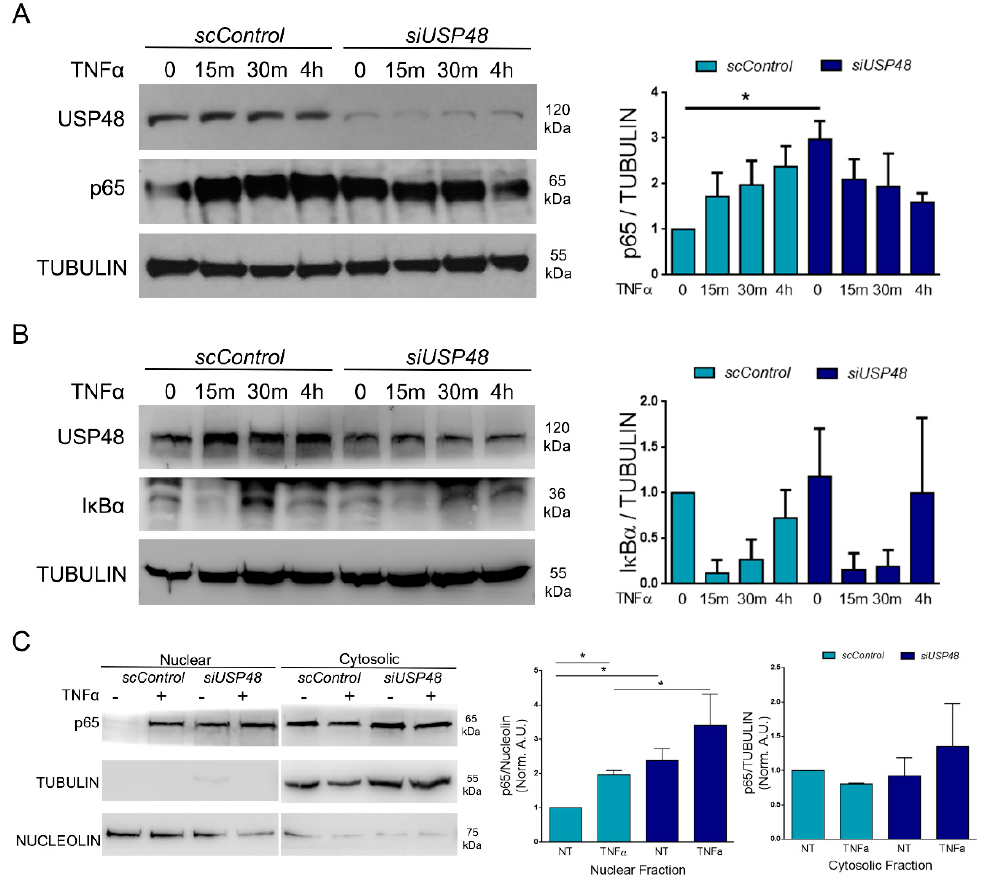
Figure 4. USP48 downregulation stabilizes p65, mainly in the nuclear compartment. USP48 expres- sion was downregulated in hTERT-RPE1 cells at both basal conditions (NT) and after treatment with TNF α at several different time points. Cells were harvested and processed for immunoblotting. ( A ) Densitometric quantification indicates that p65 levels significantly increased in NT cells. ( B ) No changes were detected in I κ B α expression levels. ( C ) Nuclear and cytosolic extracts were prepared for immunoblotting with anti-USP48 and p65 antibodies. Anti-nucleolin (nuclear) and anti-tubulin (cytosolic) were used to detect both enrichment and contamination of fractionated cell samples. p65 levels increased specifically in the nuclear compartment when USP48 is downregulated. Images represent one of three ( A , C ) or four ( B ) independent experiments. Statistical analysis by Kruskal Wallis in ( A , B) : * p -value ≥ 0.05 and by Student’s t -test in ( C ): * p -value ≥ 0.05.